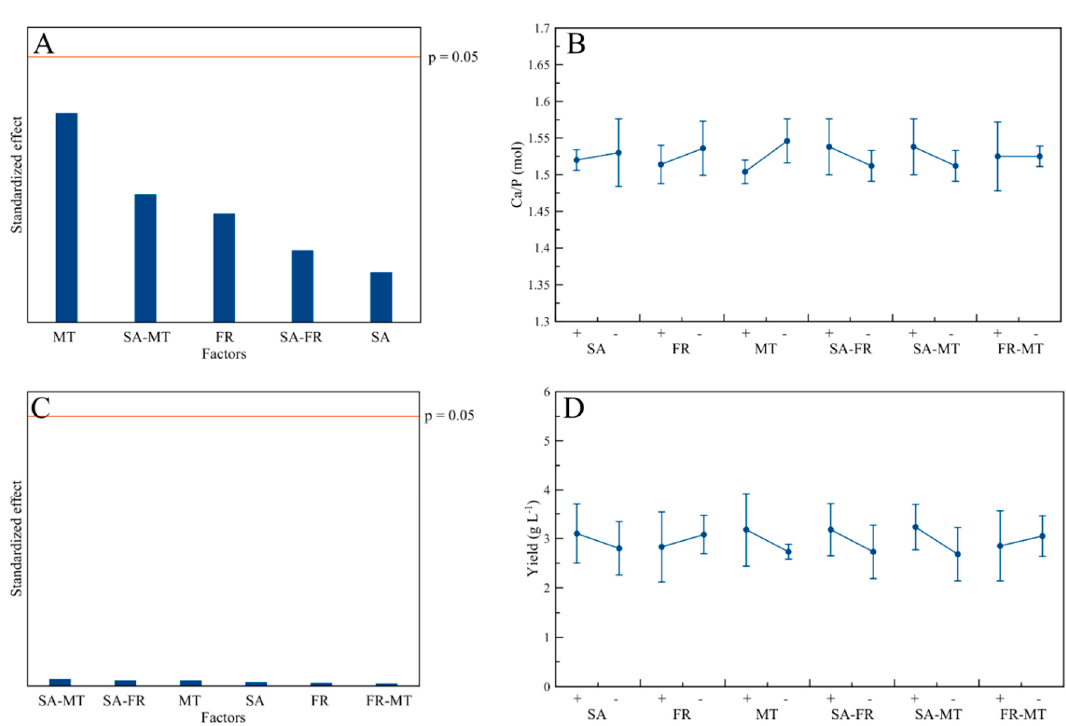
Figure 4. ( A , C ) Pareto chart of relevant standardized effects at the confidence limit of 95% and ( B , D ) plot of marginal means for ( A , B ) Ca/P ratio and ( C , D ) yield.